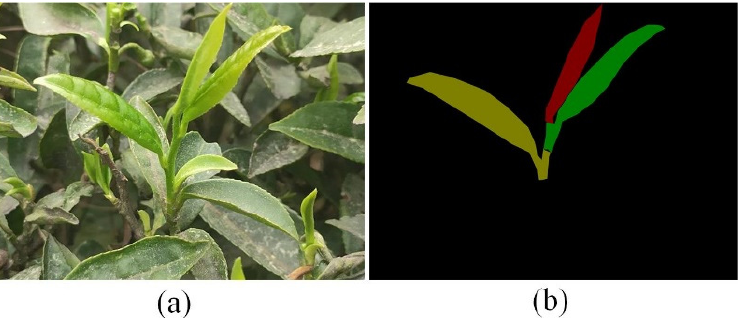
Figure 2. Tea sprout image and its corresponding visualization label. ( a ) Tea sprout image; ( b ) visualization label.